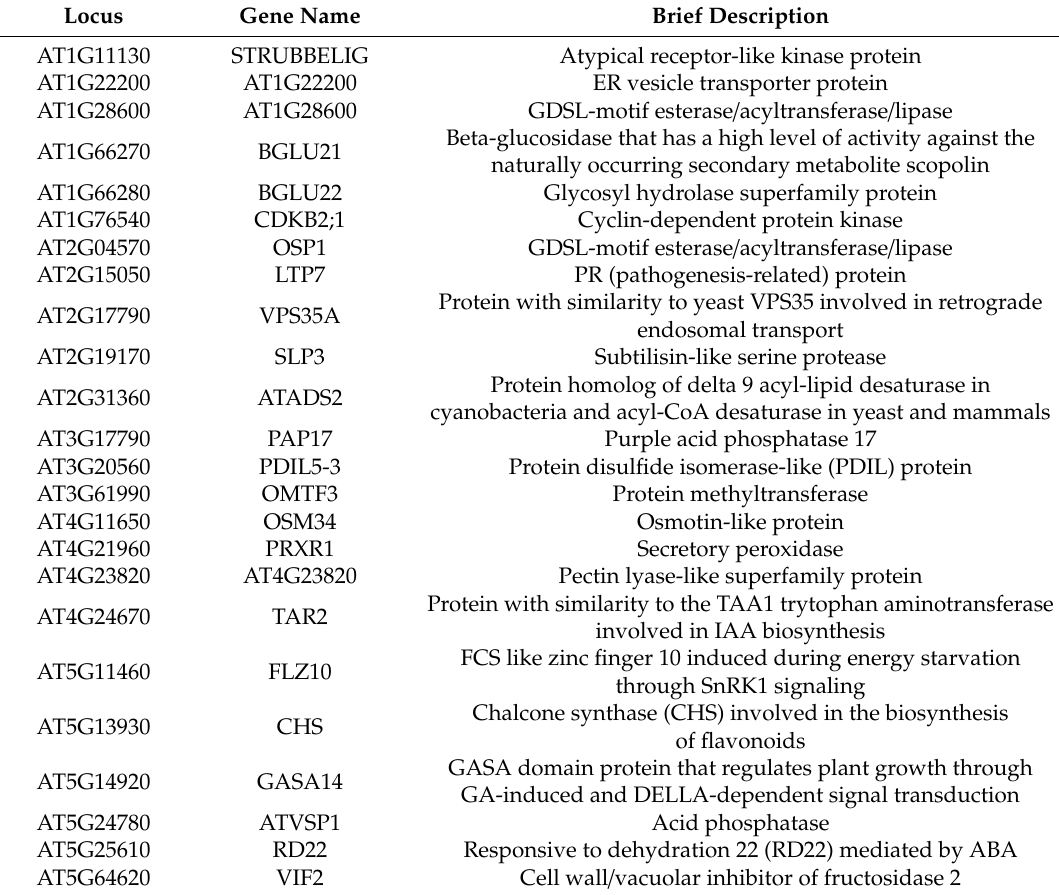
Table 4. Lists of proteins that specifically downregulated by ER stress in Col relative to L er .